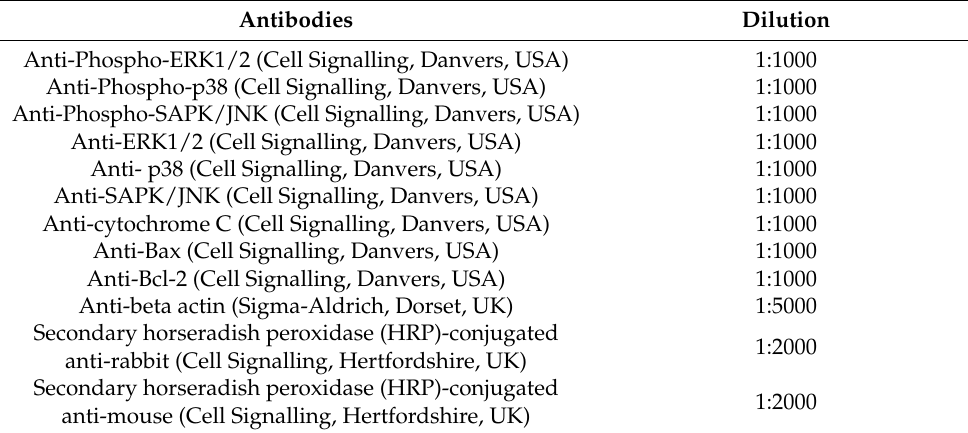
Table 1. Antibodies used for the analysis of protein expression. Antibodies